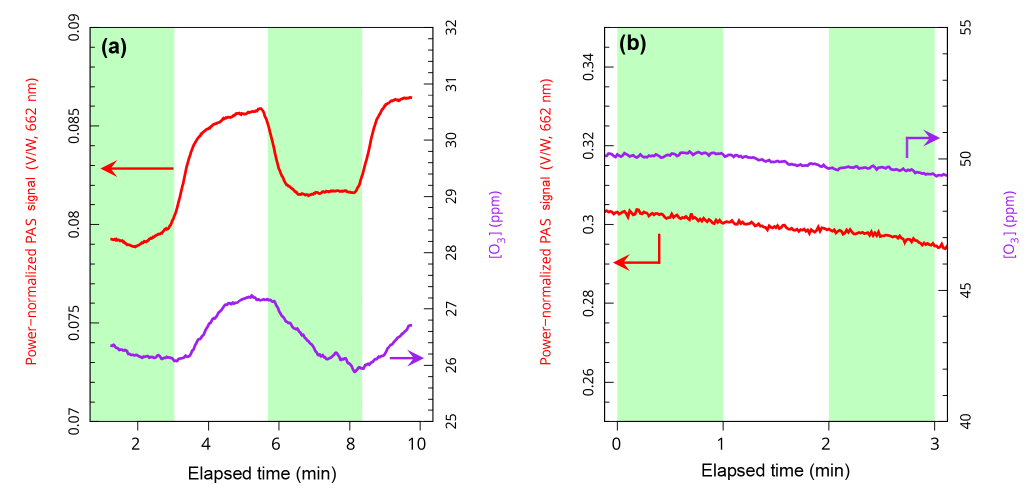
Figure 3. Photolysis of ozone in the PAS. (a) Response of 662nm PAS signal and [O 3 ] as measured with the 662nm CRD to irradiation at 532nm with no oxygen present and (b) with 5% oxygen present. Green shaded regions represent times when the 532nm laser was turned on and white regions when it was off. The slight downward drift evident is likely from a decreasing O 3 concentration as the trap becomes